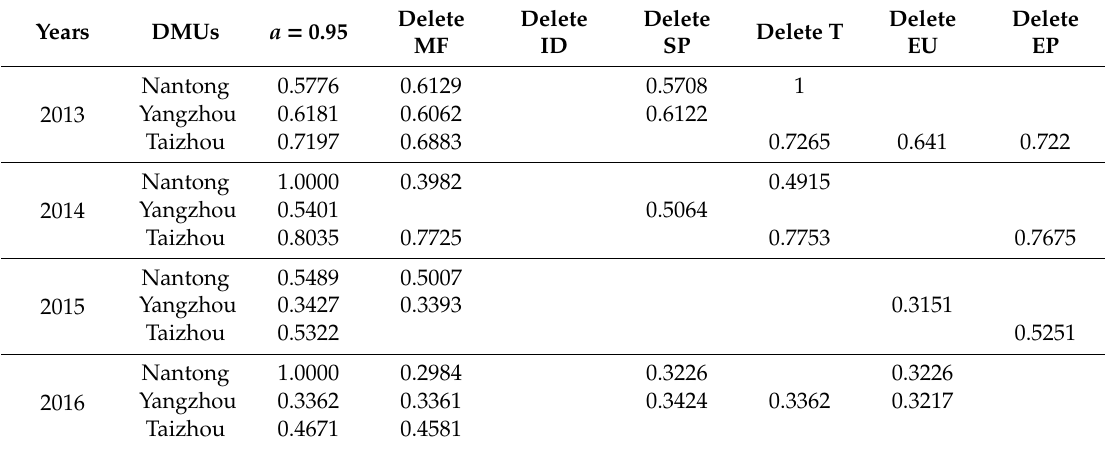
Table A9. The changes of stochastic e ffi ciency value by deleting grouping input variables in Central Su ( α =